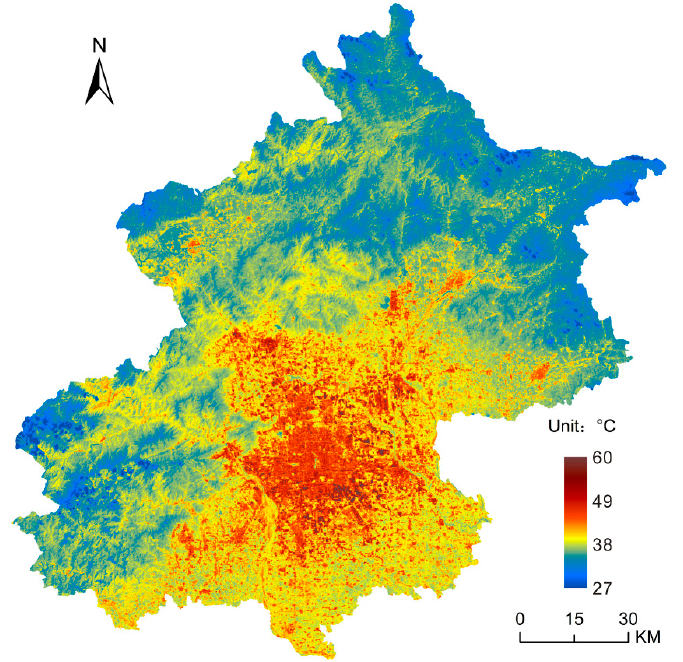
Figure 5. Daytime land surface temperature in Beijing.